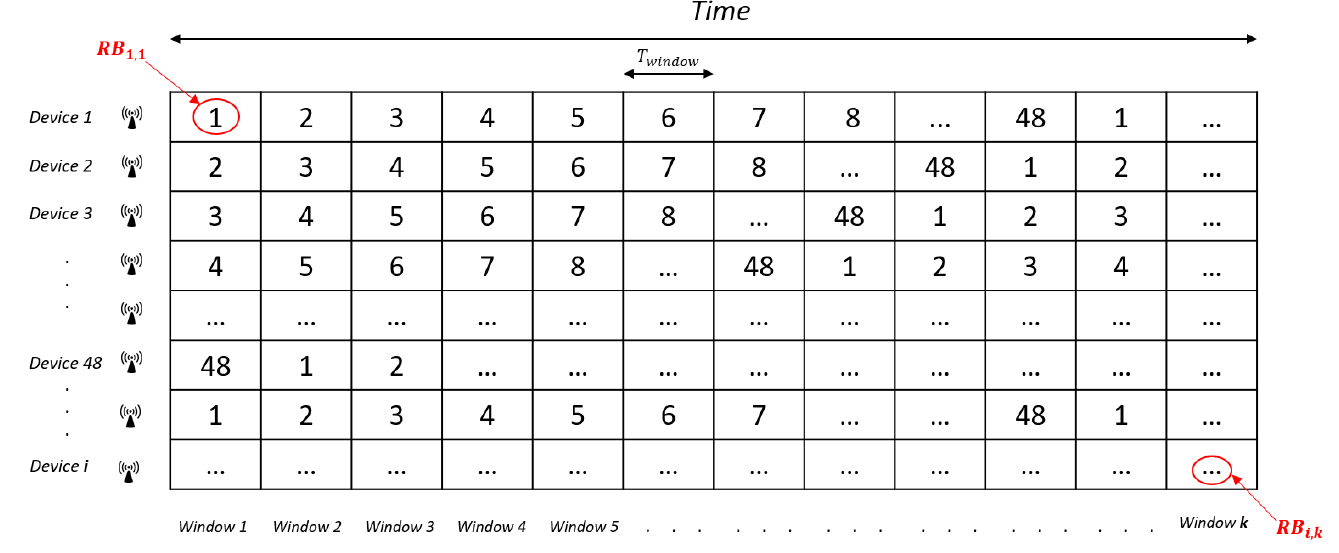
Figure 4. Resource block matrix RB matrix